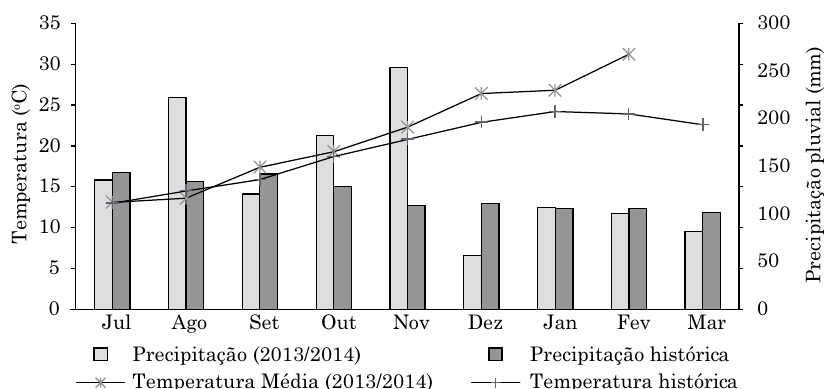
Figura 1. precipitações pluviais acumuladas na estação experimental agronômica da Universidade Federal do rio grande do Sul durante período experimental (2013/2014) e precipitações e temperaturas médias